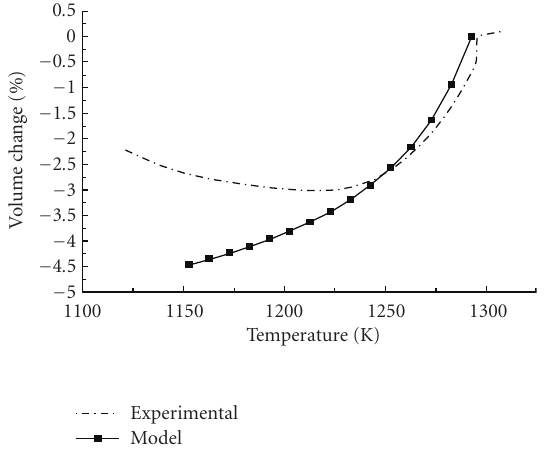
Figure 9: Experimental and modeling results of the solidification shrinkage in Cu-5Sn-5Pb alloy.